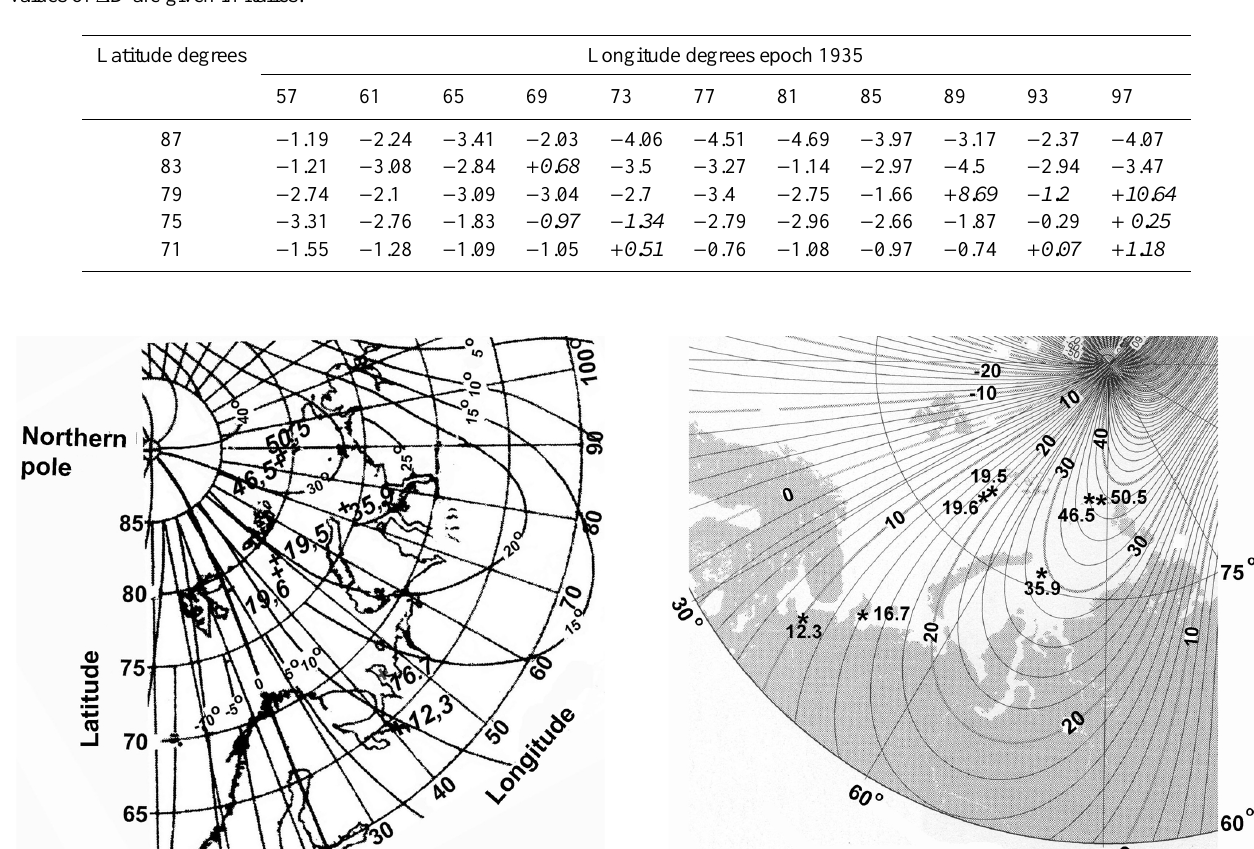
Table 3. Di ff erences between experimental and model D at the nodes of the grid with a spacing of 4 ◦ in the Arctic region. The anomalous values of ∆ D are given in italics.